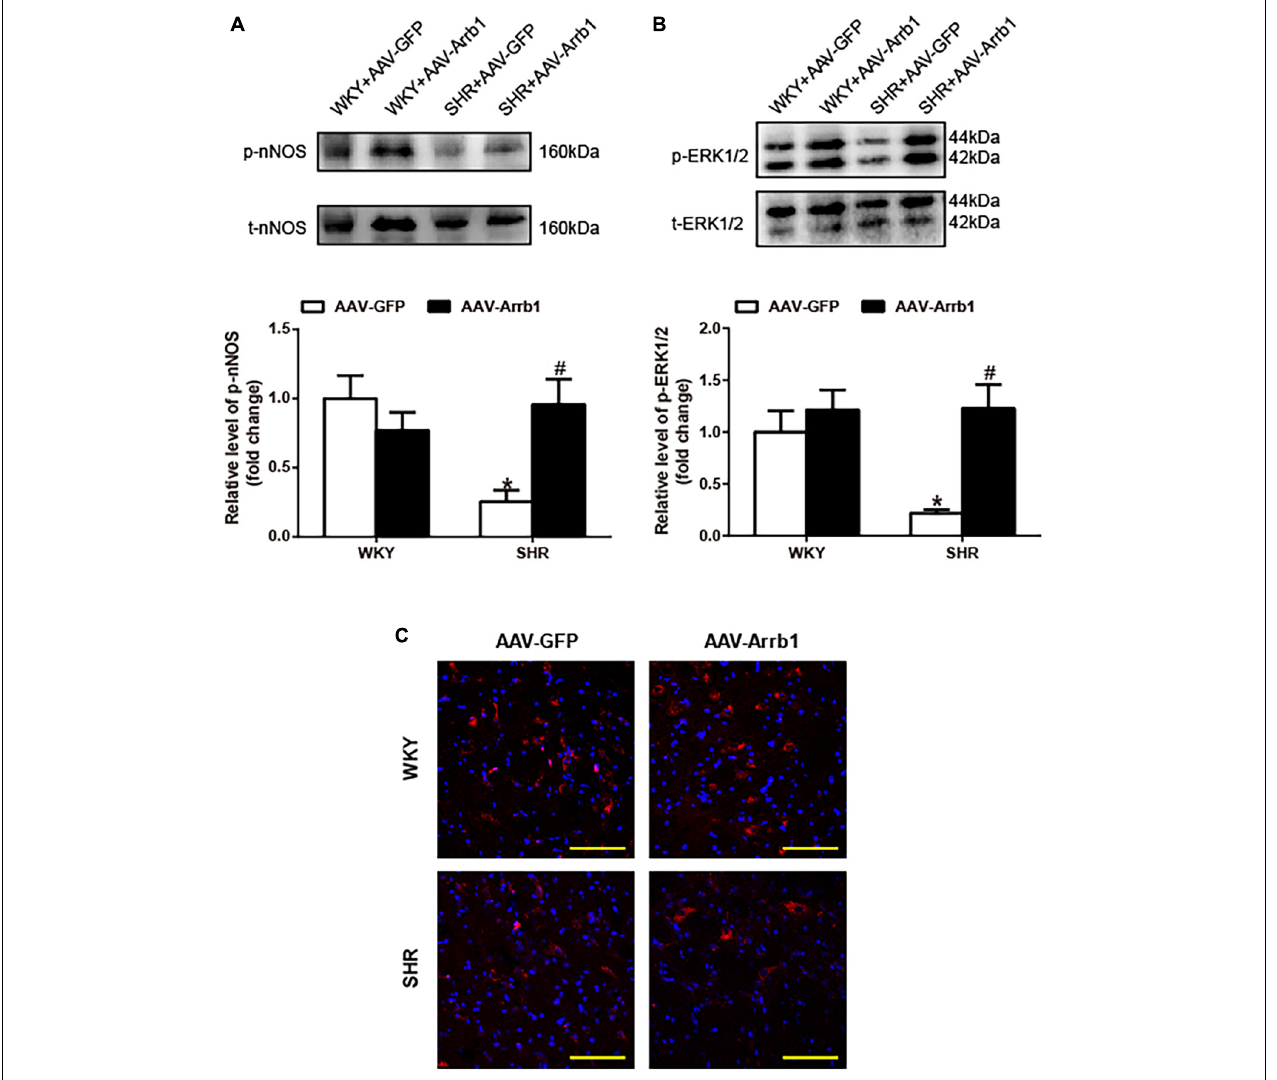
FIGURE 2 | Effects of overexpression of β -arrestin1 on nNOS and ERK1/2 phosphorylation in the RVLM of SHRs. Representative gel bands (top) and quantification data (bottom) of phosphorylated nNOS (A) and ERK1/2 (B) in response to β -arrestin1 overexpression in the RVLM in SHRs. (C) Confocal microscopy photographs represent p-ERK1/2 (red fluorescence) and nucleus (blue fluorescence) in the RVLM. Scale bar = 200 µ m. n = 5 per group in A and n = 4 per group in B, * P < 0.05 vs. WKY; # P < 0.05 vs. AAV-GFP. Relative level, standardization of dividing phosphorylated values by total values. nNOS, neuronal nitric oxide synthase; ERK1/2, extracellular regulated kinase; RVLM, rostral ventrolateral medulla; SHRs, spontaneously hypertensive rats; WKY, Wistar-Kyoto; AAV, adeno-associated virus; GFP, green fluorescent